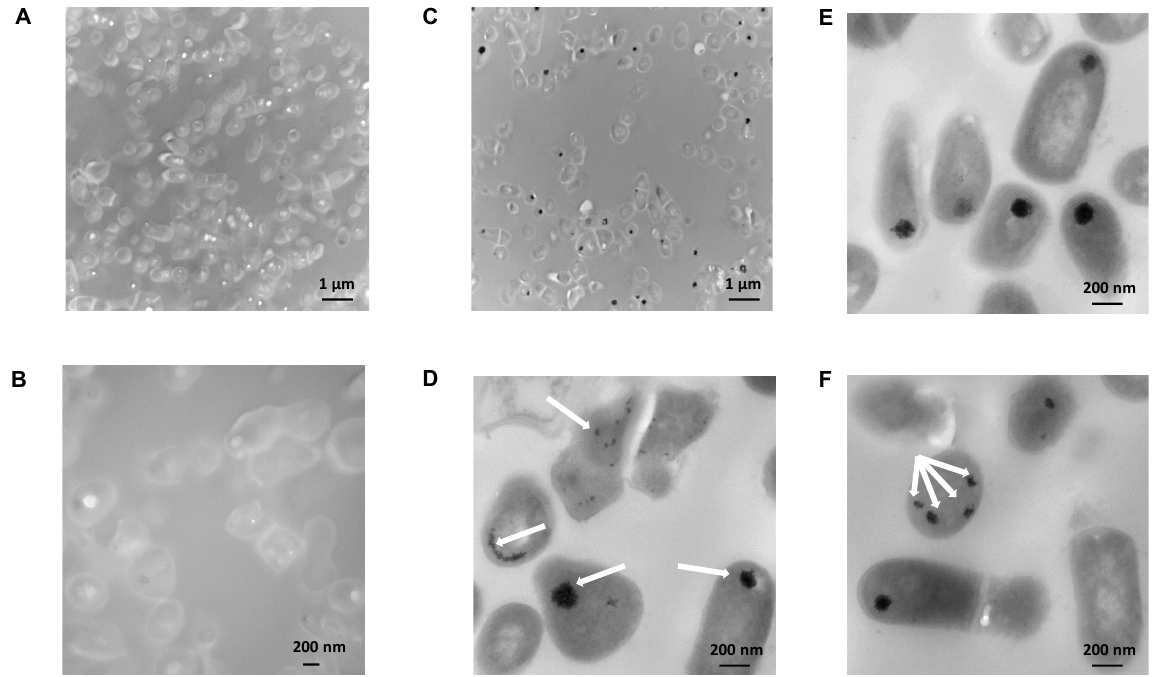
Figure 8. Transmission electron microscopy (TEM) observation of P. freudenreichii CIRM-BIA 129. ( A ) Control bacteria exposed to 25 ppm Pb(II): low magnification image. ( B ) Control bacteria exposed to 25 ppm Pb(II): high magnification image. ( C ) Bacteria treated with 0.1% Tween ® 80 and exposed to 25 ppm Pb(II): low magnification image. ( D – F ) Bacteria treated with 0.1% Tween ® 80 and exposed to 25 ppm Pb(II); high magnification image. The scale bar corresponds to 1 µm or 200 nm. Arrows indicate metal deposits.